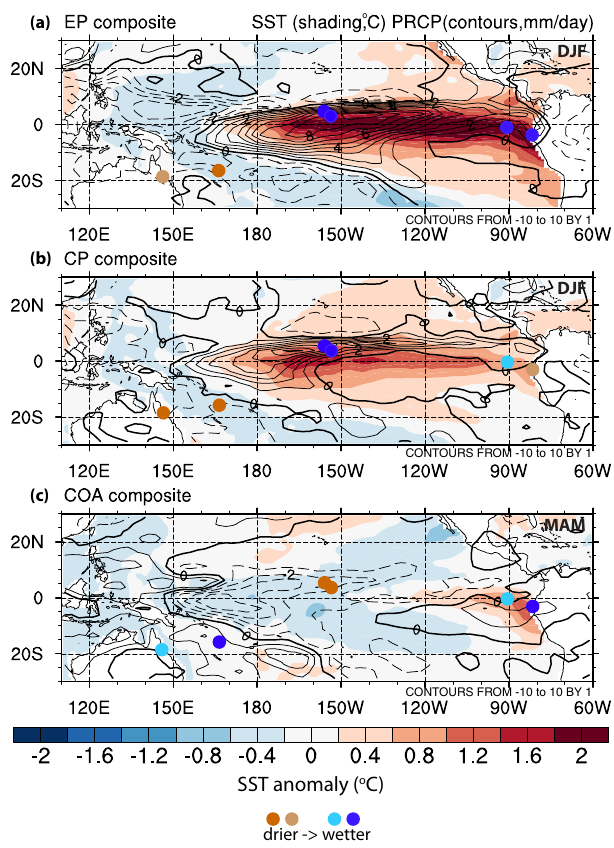
Fig. 1 | Observed hydroclimate impacts of El Niño-Southern Oscillation (ENSO) fl avors. Composite sea-surface temperature (SST; shading) and precipitation (PRCP;contours)anomaliesduringthethreepeakmonthsof a EasternPaci fi c(EP), b Central Paci fi c (CP) and c Coastal (COA) El Niño events. The peak three months for EP and CP events are December-January-February (DJF), while for COA events they are March – April – May (MAM). Solid lines indicate positive precipitation anomalies, while dashed contoursindicate a drying signal. Colored circles indicate characteristic locations of proxy records, with deeper colors indicating stronger precipitation response to each ENSO fl avor (brown for drier, blue for wetter). The proxylocationsshownare:TheGreatBarrierReef[146.5°E,18.6°S],Vanuatu[167.2 °E,15.7°S],Kiritimati[202.6°E,1.9°N],Fanning[200.6°E,3.8°N],Galapagos[270.3 °E,1.2 °S] and the Laguna Pallcacocha region in Ecuador [280.8 °E, 2.8